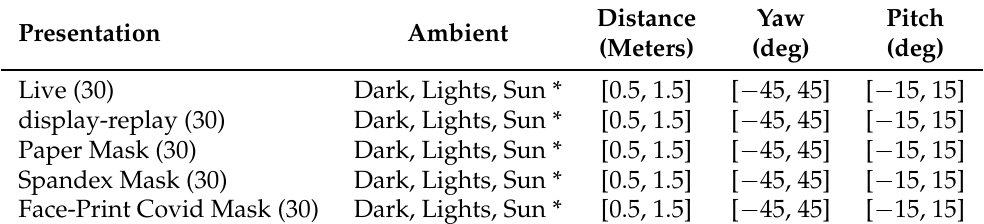
Table 1. Experiment liveliness presentation matrix. All participants are imaged under every matrix combination with the exception of sun-diffuse (all spoof with some live, indicated by